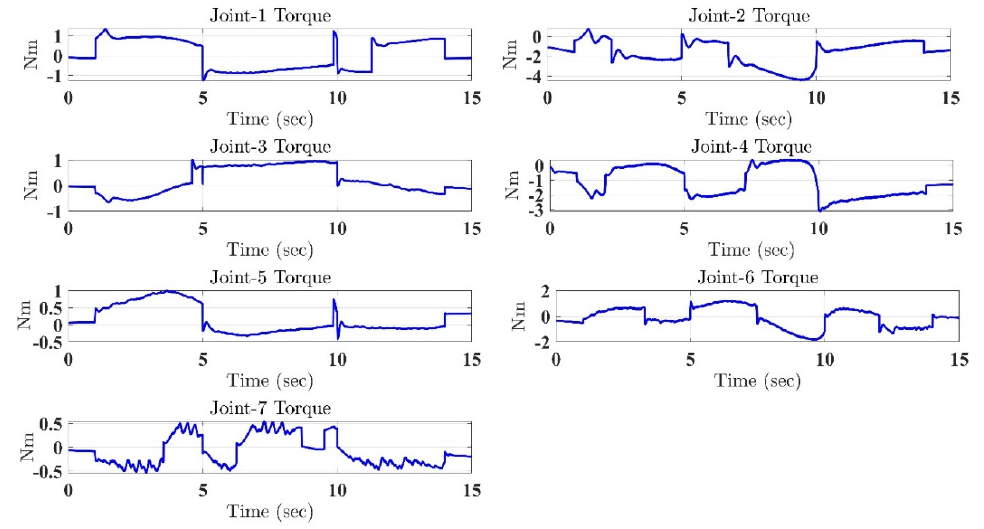
Figure 8. Control inputs under the proposed controller.